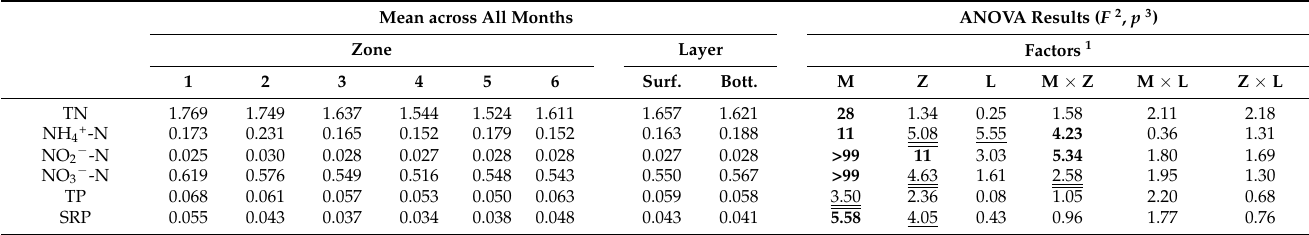
Figure 8. Example vertical distribution of Chl-a at two sites ( a ), and Chl-a maximum (D Chl-max ) (colored circles) at 18 sites ( b ) in MA. The color of the line in ( a ) shows the month corresponding to the color in ( b ). The box plot of water depth is also shown as a reference. M: middle, P: periphery. Concentrations of TN and TP varied significantly among months, whereas they varied less among zones and between layers (Table 2). The concentration of NH 4+ -N varied significantly among zones, being highest in zone 2 and lowest in zones 4 and 6. The difference was more obvious in some months (such as November, January, and March 2019), as indicated by the significant month × zone interaction. It was also significantly higher for bottom than surface. The concentration of NO 3 − -N varied significantly among zones, being highest in zone 1 and lowest in zone 6. The difference was more obvious in some months (such as April, January, and March 2019). The concentration of SRP varied significantly among zones, being highest in zone 1 and lowest in zone 4. In summary, all nutrient variables except NO 2 − -N were slightly (11–25%) higher in zones 1 and 2 than in zones 4, 5, and 6 especially in winter and early spring months. Table 2. Mean values of N and P concentrations (mg L − 1 ) at each zone and each layer in MA, and results of a three-way ANOVA without